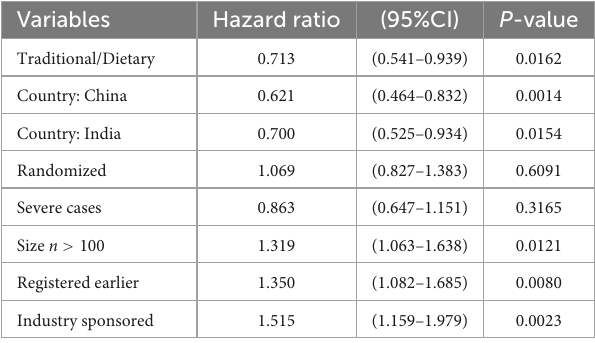
TABLE 3 Results of cox multiple regression analysis of result